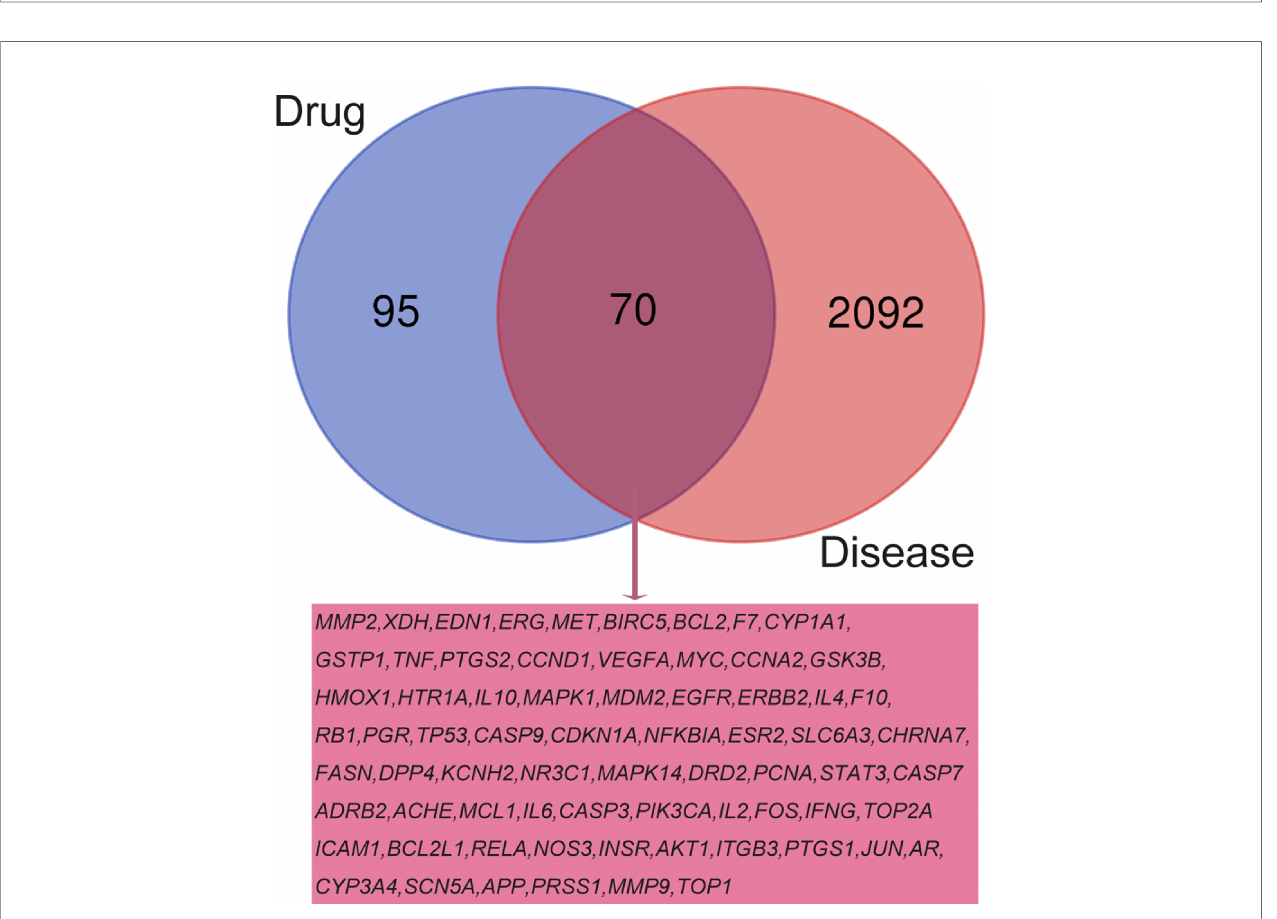
FIGURE 2 | Topological network of Drug, Chemical components, Putative target, Disease. (The red octagon represents the disease, the orange ovals represent the putative targets, the blue triangle represents the drug, and the pale blue rectangles represent the chemical components).